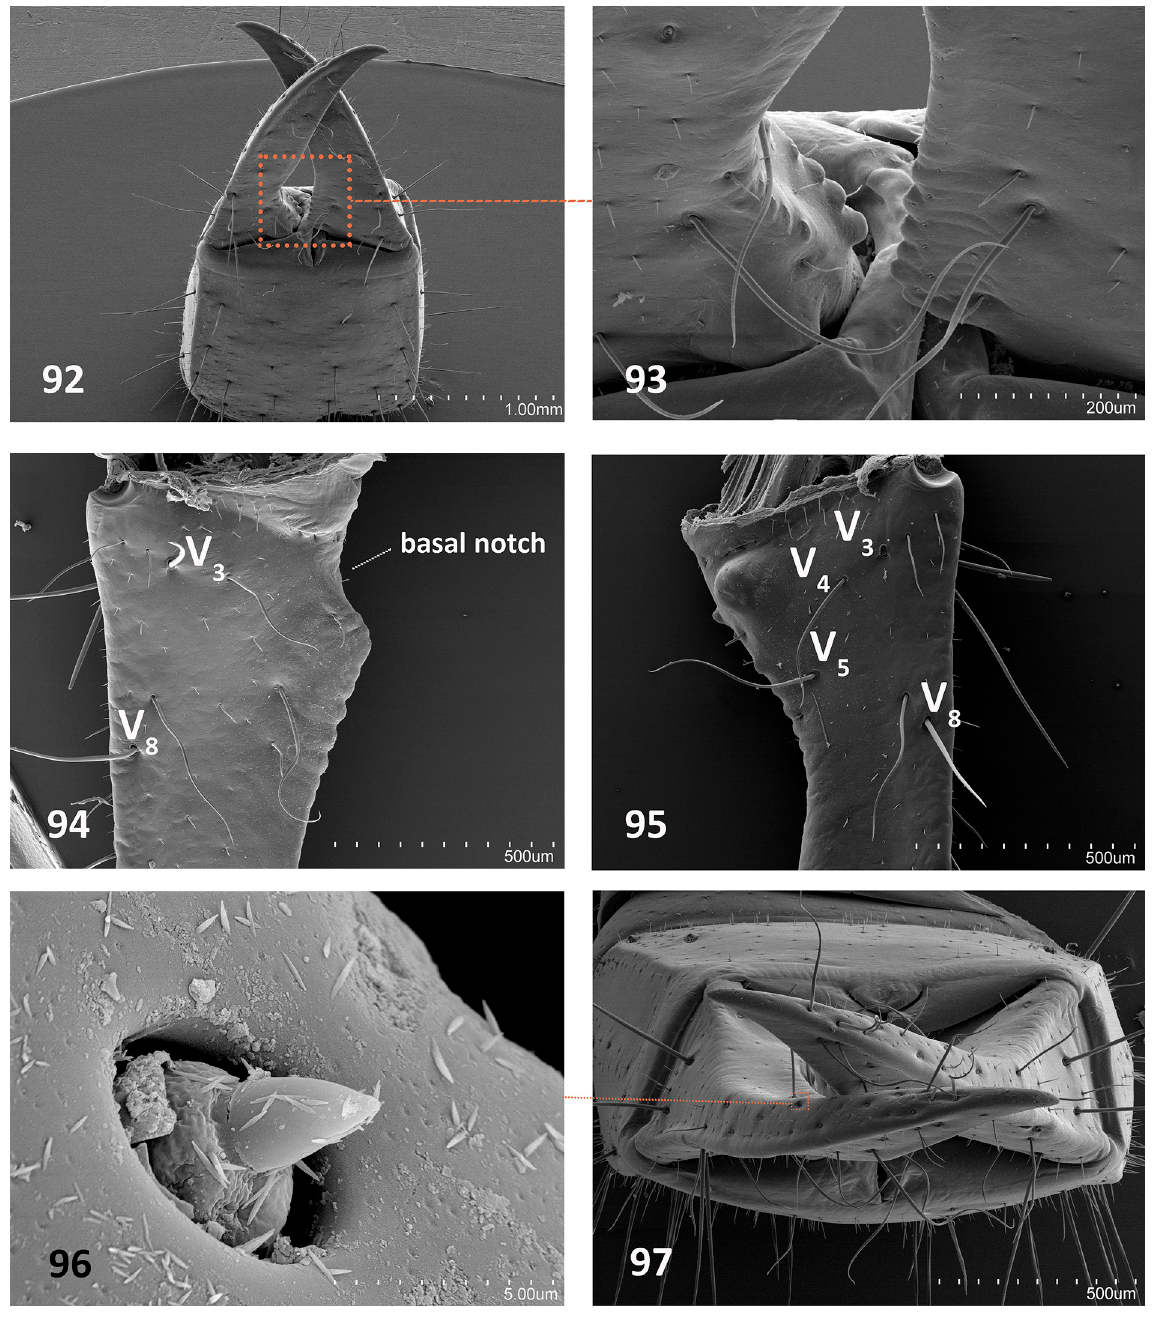
Figs 92‒97. Mueggejapyx brehieri Sendra & Komerički gen. et sp. nov. 92 . Urite X and cerci, ventral side. 93 . Proximal and ventral side of the cerci. 94 . Ventral proximal portion of the left cercus. 95 . Ventral proximal portion of the right cercus. 96 . Conical sensillum of the cerci. 97 . Cerci, caudal view. See Material and methods for